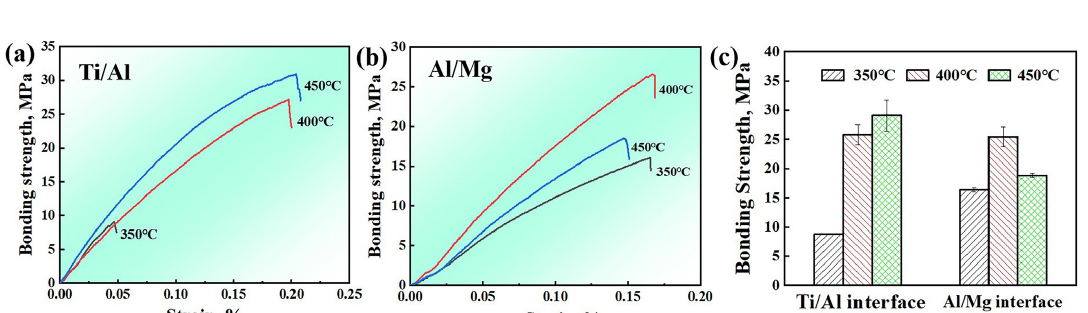
Figure 8. Variations of interface bonding strength for LMCs prepared at different hot-pressing temperatures: bonding strength-strain curves of (a) Ti/Al interfaces and (b) Al/Mg interfaces, (c) variations of bonding strength for Ti/Al and Al/Mg